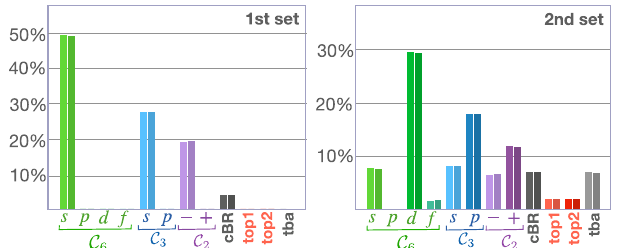
FIG. 10. Comparison of the (quasi-) BR distribution calculated using the NN and the Schrödinger equation. The probability bars for a given (quasi-) BR but different methods are shown side by side. The results obtained using the Schrödinger equation are plotted in slightly darker